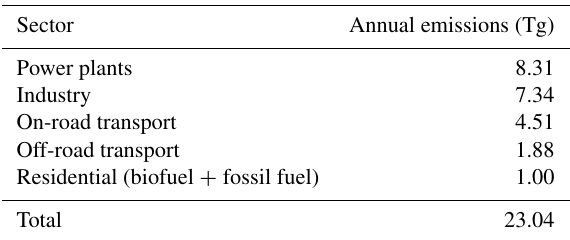
Table 2. Anthropogenic NO x emissions by sector in China for 2006 from the MEIC